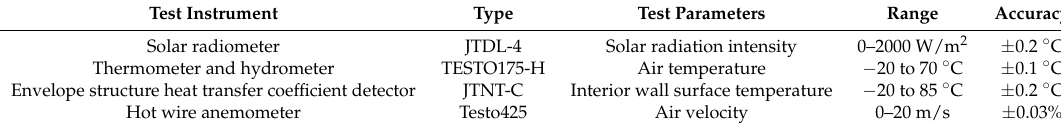
Table 1. Models and parameters of the measuring instruments.